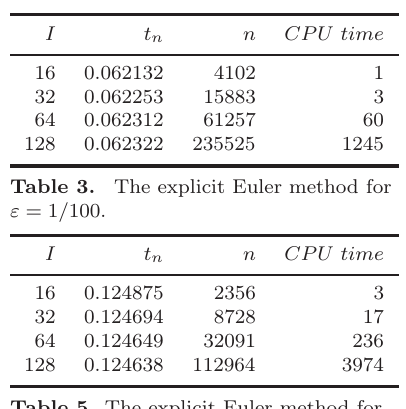
Table 2. The implicit Euler method for ε = 1 .